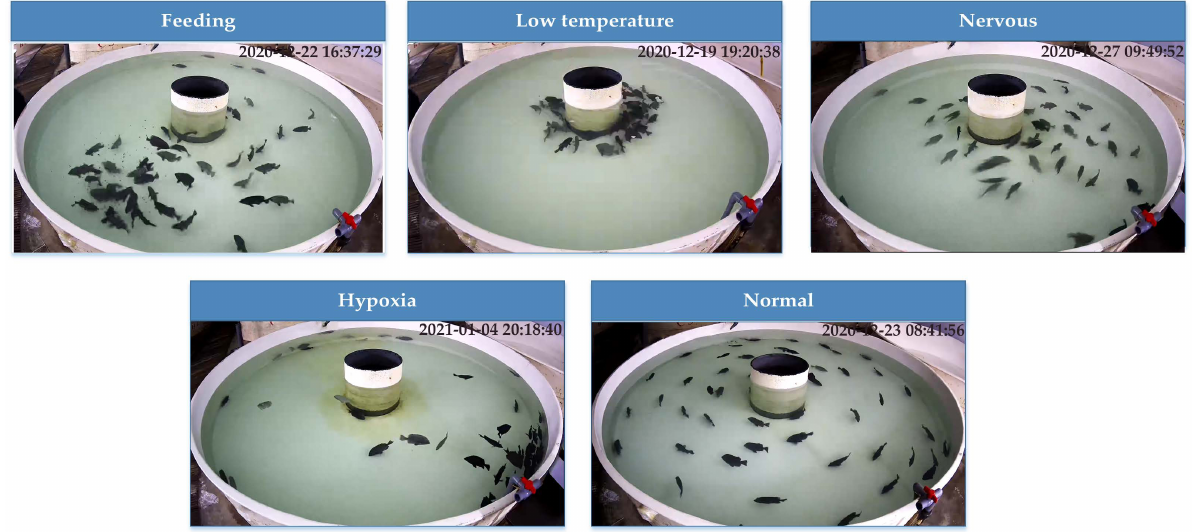
Figure 2. Keyframes of the fish behavior dataset.